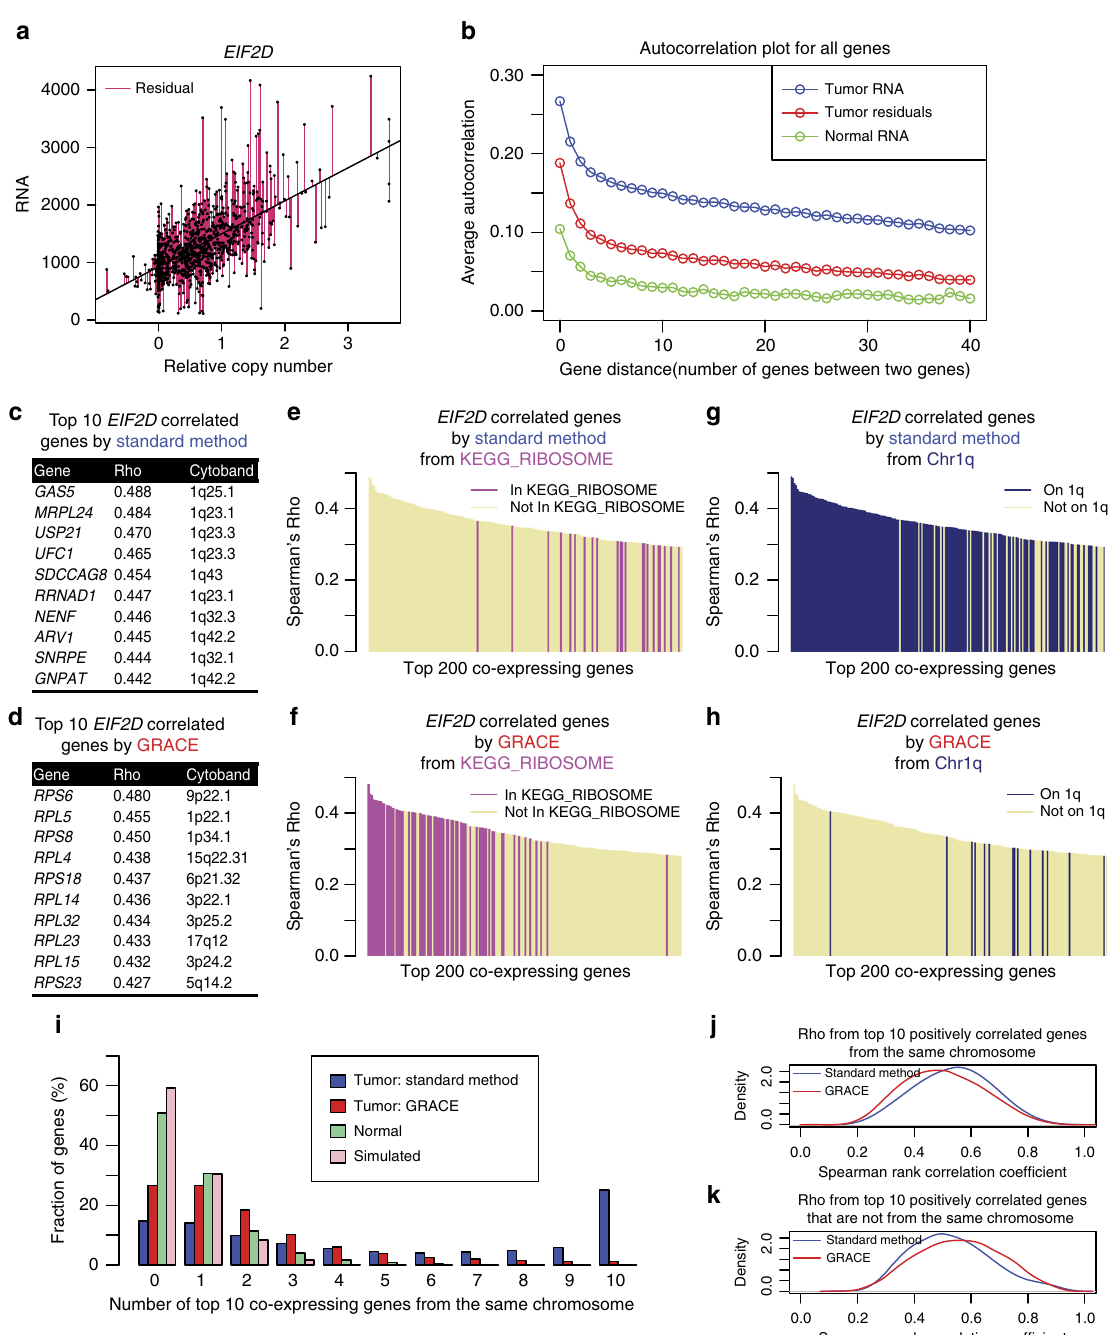
Fig. 2 Genomic regression analysis of co-expression (GRACE) corrects for correlation bias due to copy number variation. a Relative copy number levels vs. RNA levels of EIF2D for all 1075 tumor samples. The residuals from the linear regression model fi tted with all 1075 tumor samples were marked by purple lines. b Average autocorrelation of neighboring genes in TCGA BRCA samples. Correlations between neighboring genes separated by 0 – 40 genes in between were calculated as autocorrelation for each sample. The average of autocorrelations was taken for 1075 tumor samples and 112 normal samples. The autocorrelation of neighboring genes based on copy number-adjusted expression levels variation (tumor residuals) was markedly reduced compared to autocorrelation based on tumor RNA. Average autocorrelation from normal samples represent the gene – gene autocorrelation baseline in diploid cells. c , d Top 10 EIF2D correlated genes by standard method ( c ) or GRACE ( d ) based on Spearman correlation. Top 10 EIF2D correlated genes by standard method are all located in cytoband 1q whereas top 10 EIF2D correlated genes by GRACE are all outside cytoband 1q and are all ribosomal protein genes. e , f Enrichment of KEGG_RIBOSOME genes from the top 100 EIF2D correlated genes by standard method with a p value of 0.10 ( e ) or by GRACE with a p value of 9.0e − 143 ( f ). g , h Enrichment of genes from chromosome 1q in the top 100 EIF2D correlated genes by standard method with a p value of 8.7e − 119 ( g ) or by GRACE with a p value of 0.99 ( h ). i Relative frequency distribution of chromosomal neighbors in top 10 co-expressing genes for all genes. GRACE markedly reduced the number of chromosomal neighbors in the top 10 co-expressing genes. j , k Kernel density estimation plots that visualize the distribution of pooled Spearman rank correlation coef fi cients for top 10 co-expressing genes from the same chromosome ( j ) or not from the same chromosome ( k ). Compared to the standard method, GRACE decreased intra-chromosomal gene – gene correlation and increased inter-chromosomal gene – gene correlation. All analyses are based on TCGA BRCA